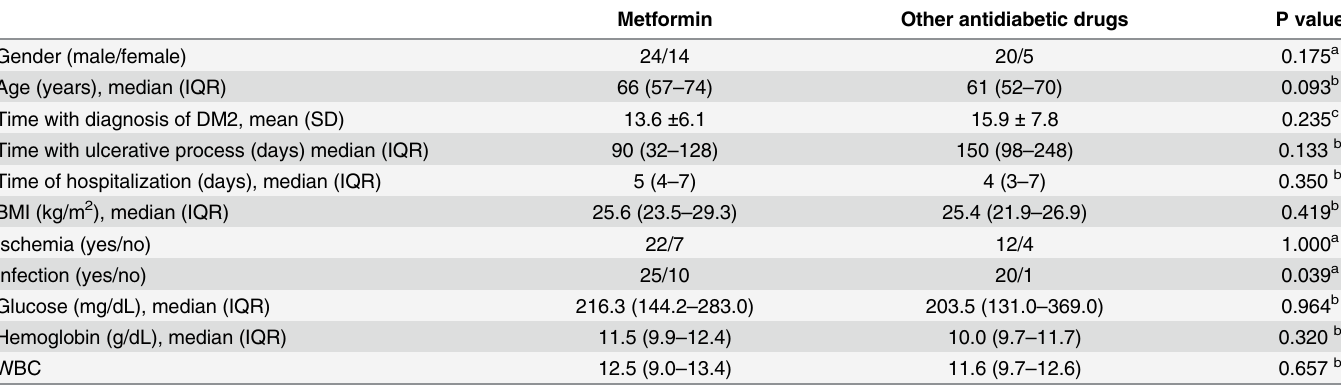
Table 1. Clinical features of patients with foot